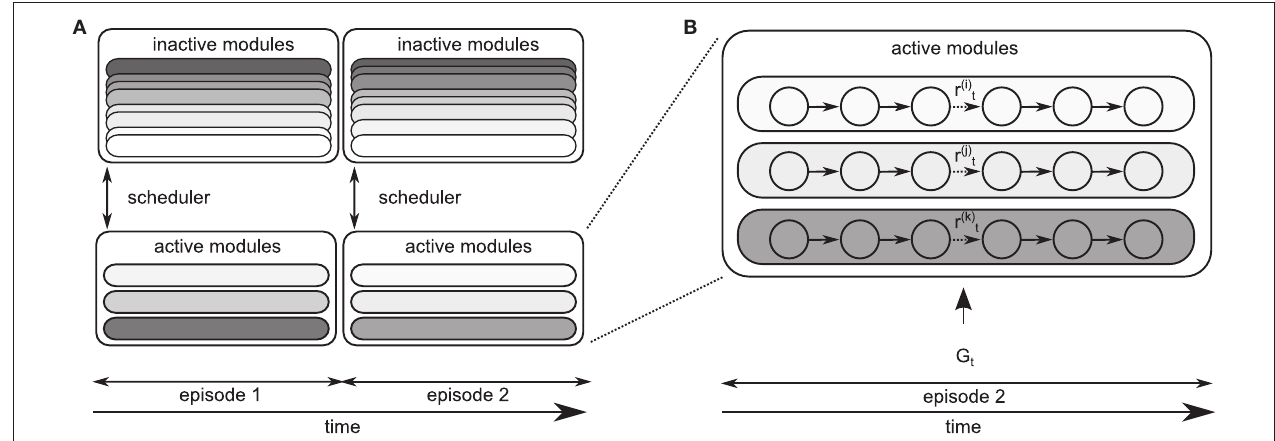
Figure 4 | Schematic representation of the modular credit assignment problem. (A) In any period during behavior there is only a subset of the total module set that is active. We term these periods episodes. In the timecourse of behavior, modules that are needed become active and those that are no longer needed become inactive. The vertical depicts two sequential episodes of three modules each, denoted with different shadings. The vertical arrows denote the scheduler’s action in activating and deactivating modules. Our formal results only depend on each module being chosen sufficiently often and not on the details of